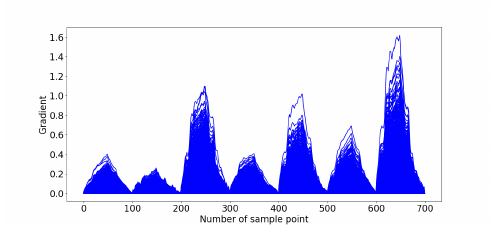
Figure 23: GV of non-overfitting TTSCA big on